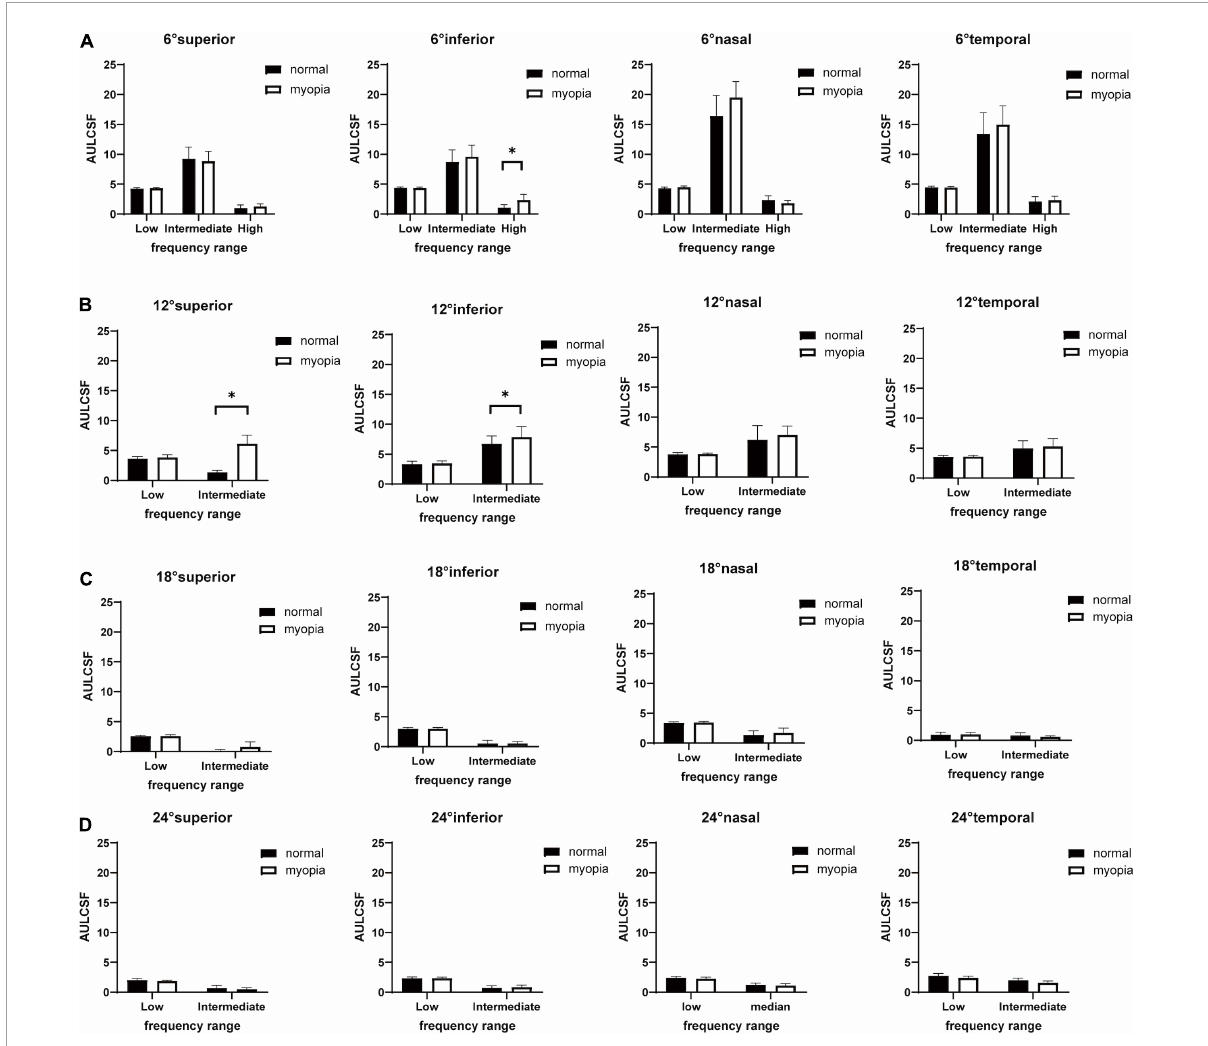
FIGURE3 Histographs of low-, intermediate-, and high-SF AULCSFs (Mean ± SD) of myopes and emmetropes at superior, inferior, nasal, temporal visual fields locations at (A) peripheral 6 ◦ , (B) peripheral 12 ◦ , (C) peripheral 18 ◦ , (D) peripheral 24 ◦ . The plot shows the mean and 95% confidence limits. The white columns denote the myopia group and the black columns denote the normal group. Significant differences ( ∗ P < 0.05, Post-hoc Bonferroni test) between myopes and emmetropes are indicated by a ( ∗